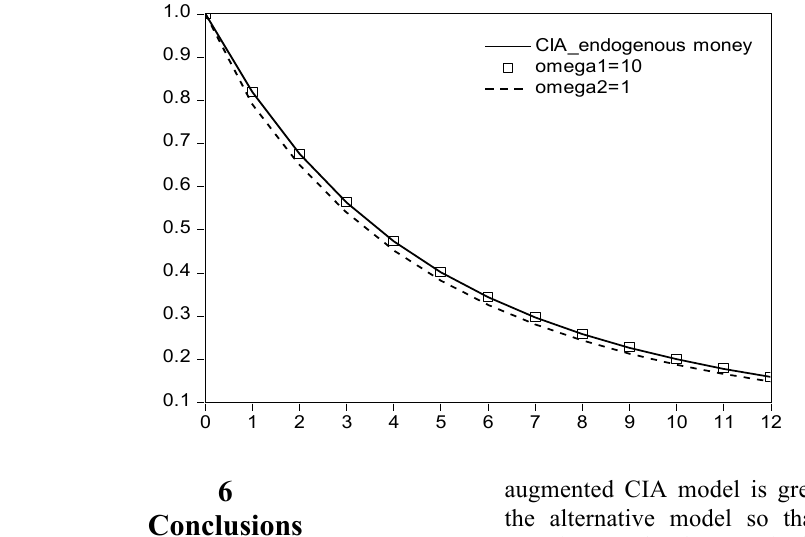
Comparison with benchmark model with endogenous money by changing